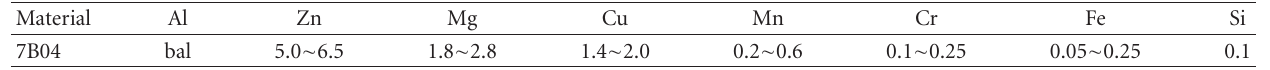
Table 1: Chemical composition of 7B04 Aluminum alloy (wt.%).